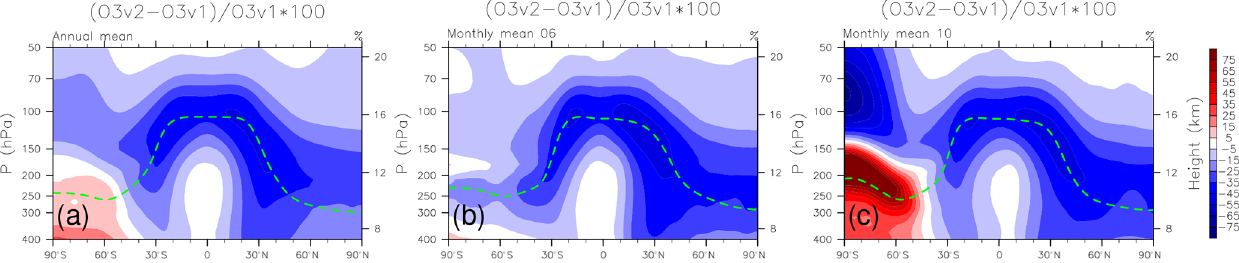
Figure A1. Relative changes in zonal mean ozone profiles (%) from O3v1 to O3v2 at the UT–LS region (50–400hPa) for (a) annual, (b) June, and (c) October means.